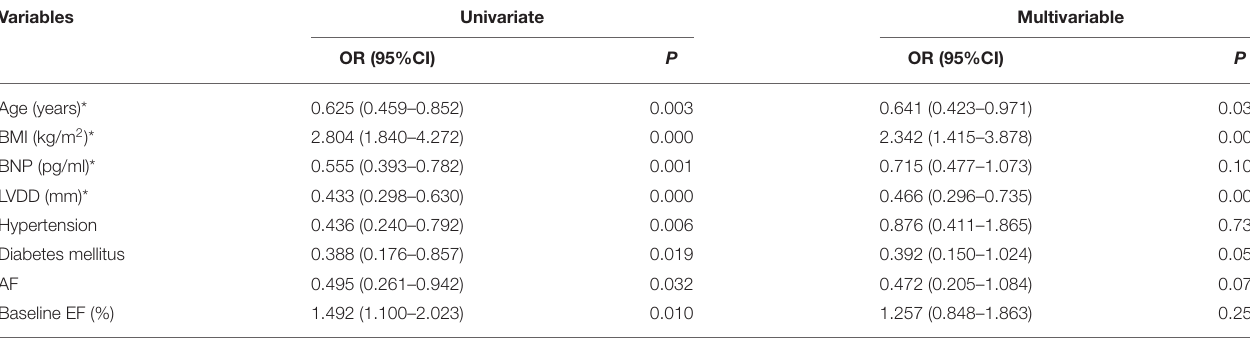
TABLE 4 | Logistic Regression Analysis of baseline patient characteristics associated with HFrecEF (vs. persistent HFrEF).